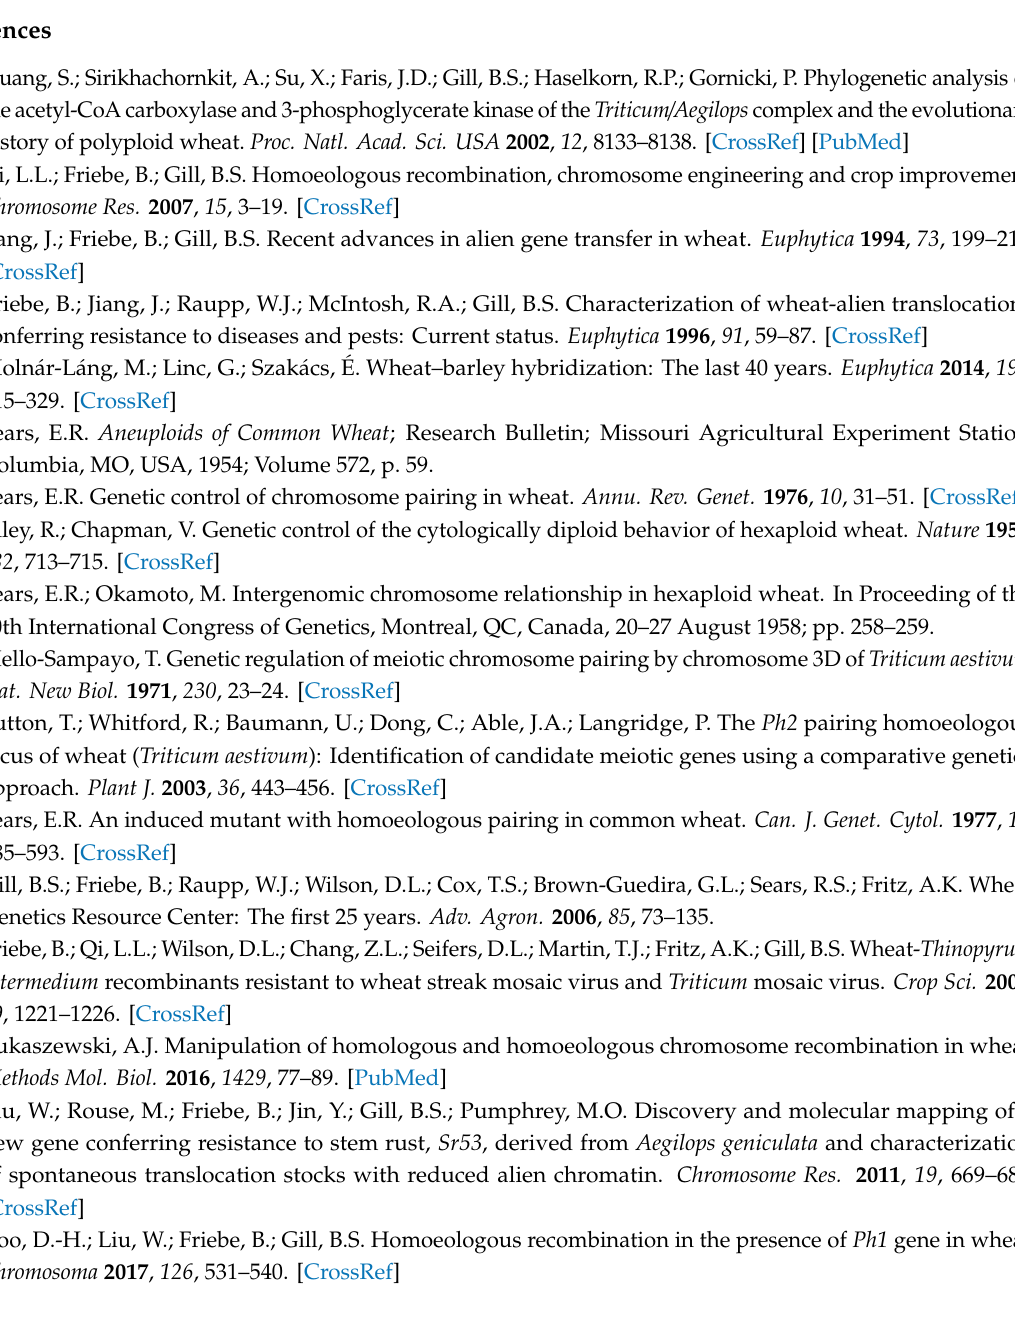
Figure S1: Genomic in situ hybridization (GISH)-based identification of recombinant chromosomes derived from plants with 5M g #1 and without Ph1 ( Hpp-5M g / ph1bph1b ). Table S1: Plant materials used in preparing the chromosome painting